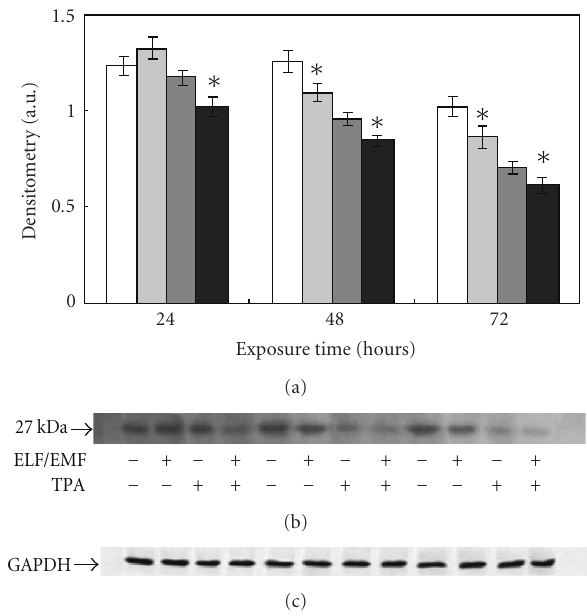
Figure 8: E ff ect of ELF-EMFs exposure and TPA treatment on p27 levels. Autoradiographs of p27 expression in Caco cells exposed to ELM-EMFs. The densitometric analysis from six separate blots pro- vided for quantitative analysis is presented (a) and a representative Western blot is shown (b). Equal protein loading was verified by using an antibody directed against GAPDH (c). Caco cells were cultured with or without 0.1 μ M TPA for 24, 48, and 72 hours. After harvesting and lysing the cells, samples were subjected to SDS- PAGE and electroblotted on a polyvinylidene fluoride membrane. The immunostaining was performed using anti-p27 antibodies, and the detection was executed by the Enhanced Chemiluminescence western blotting analysis system. Data points marked with an asterisk are statistically significant compared to their respective not exposed control cells ( P < .